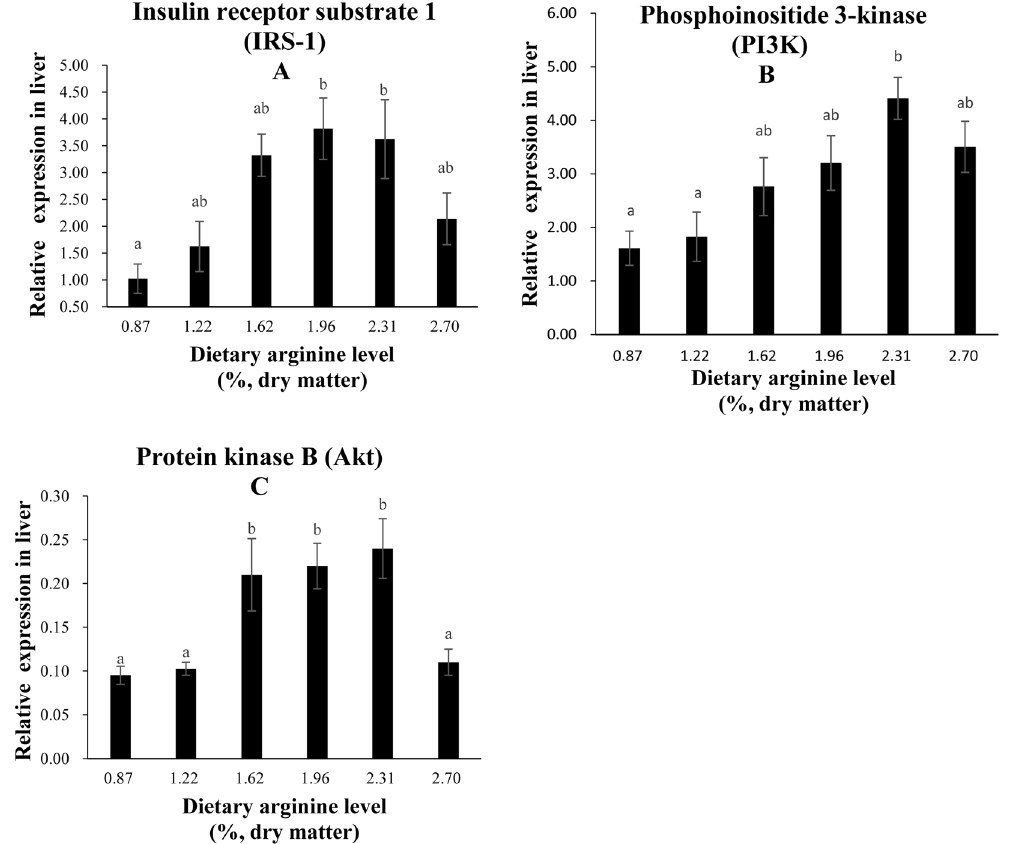
Figure 1. Relative expressions of insulin signaling pathway. Such as IRS-1 ( A ), PI3K ( B ) and Akt ( C ) genes in the liver of blunt snout bream fed diets with different arginine levels. Data are expressed as means with SEM. Value with different superscripts are significantly different ( P < 0.05